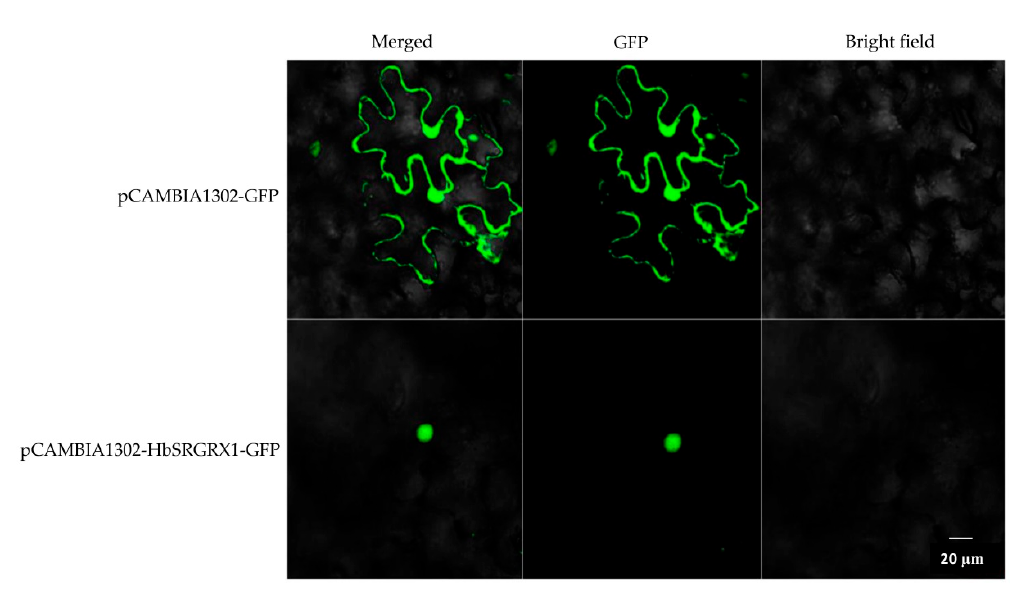
Figure 2. Subcellular localization of HbSRGRX1. GFP alone (top row) was localized throughout the whole cell and pCAMBIA1302-HbSRGRX1-GFP (bottom row) in the nuclei of tobacco epidermal cells. Bar = 20